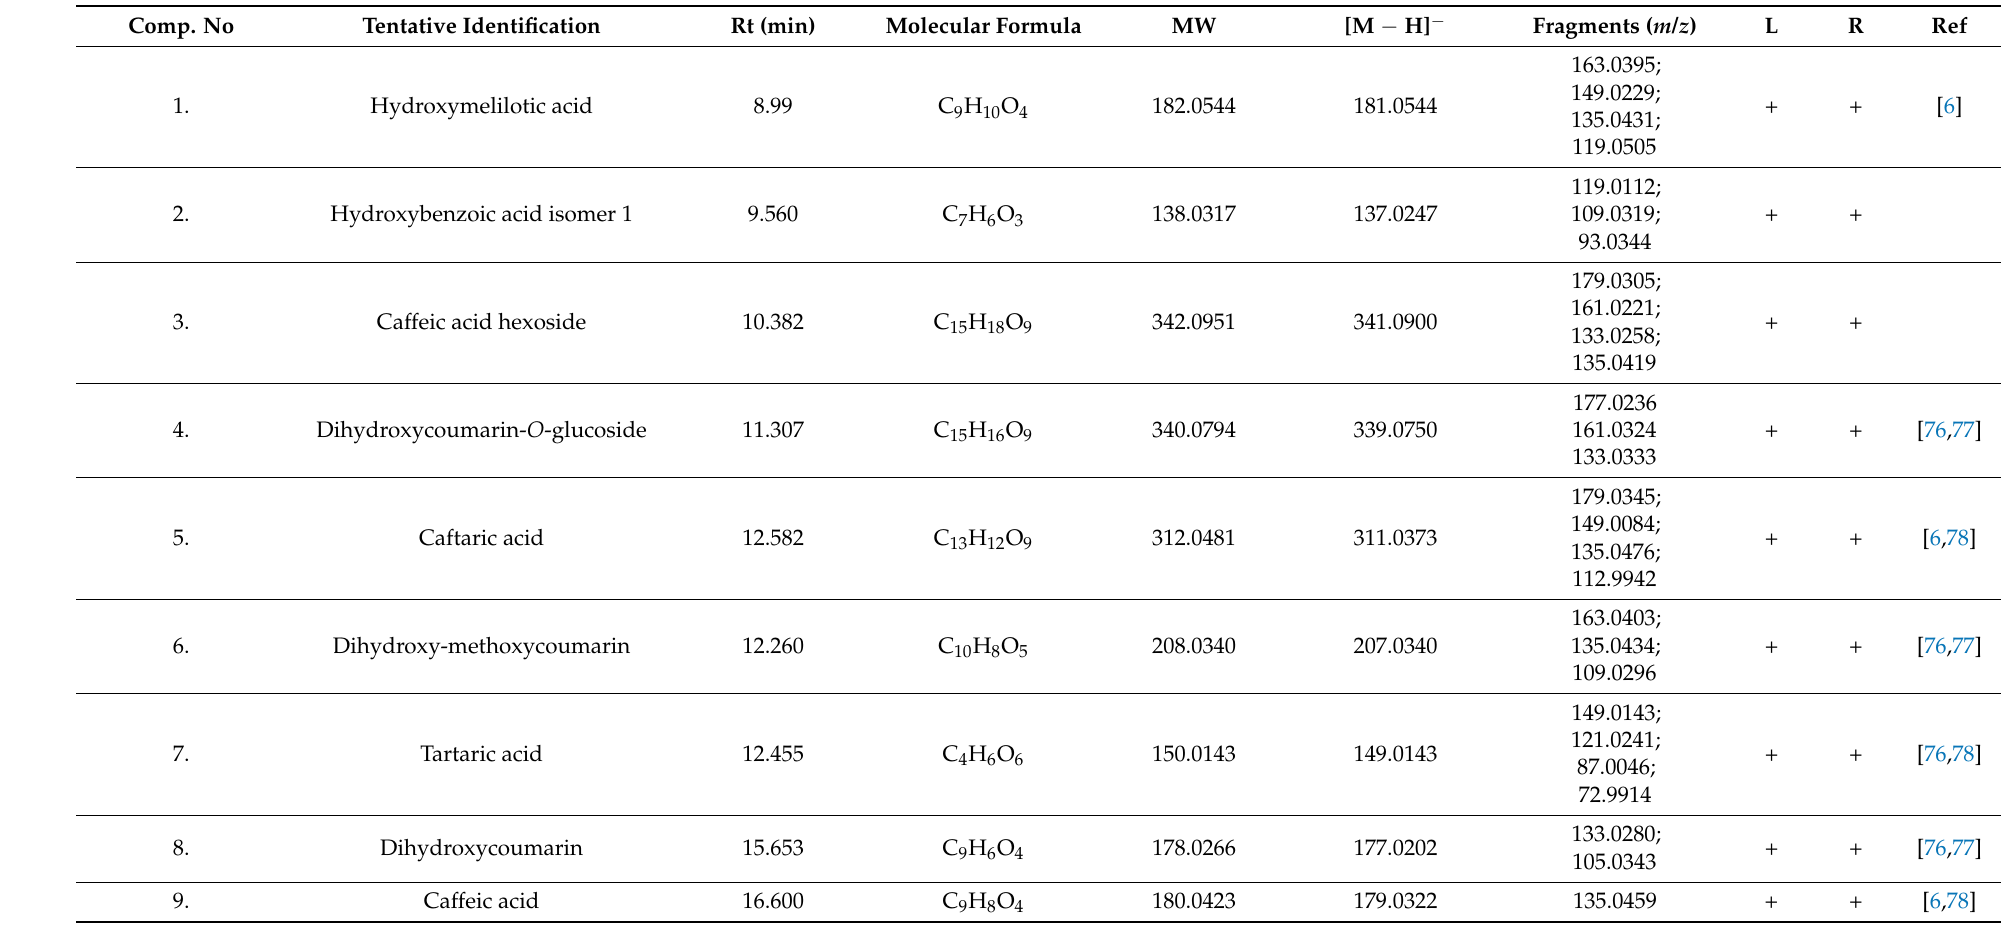
Table 3. The chemical composition of the studied aboveground ( L ) and root ( R ) P. vulgaris methanolic